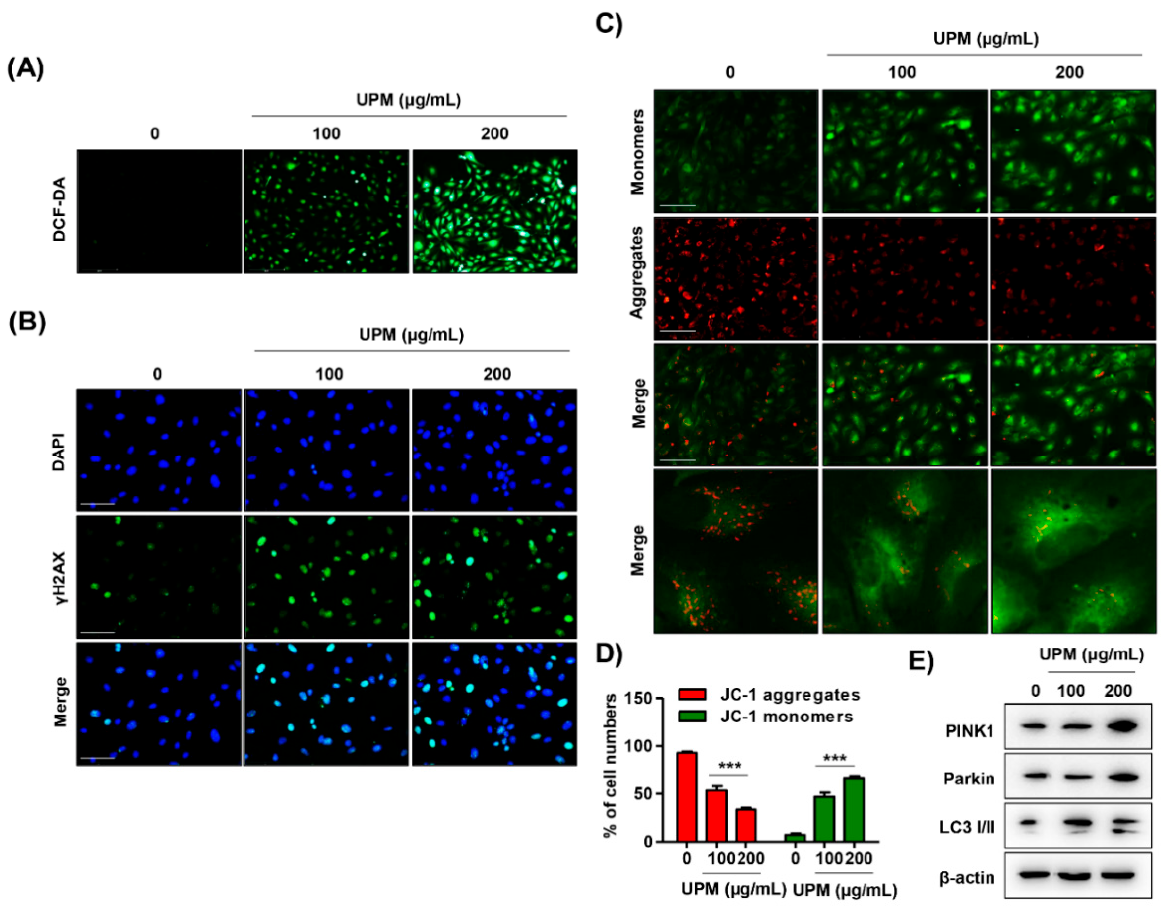
Figure 4. UPM triggers DNA and mitochondrial disorders in ARPE-19 cells. ( A ) Fluorescence images of ARPE-19 cells stained with 10 µ M DCF-DA. Intracellular reactive oxygen species (ROS) generation was identified as a DCF-DA intensity that was observed under a fluorescence microscope. Scale bar: 200 µ m. ( B ) Fluorescence images of the cells immunostained with γ H2AX antibody (green) and visualized using a fluorescence microscope. DAPI was used to counterstain the nuclei (blue). Scale bar: 75 µ m. ( C ) Fluorescence images of the cells stained with 10 µ M JC-1 with the monomer showing green fluorescence defining low MMP ( ∆Ψ m ) and aggregates showing red fluorescence characterizing high MMP ( ∆Ψ m ). Scale bar: 75 µ m. ( D ) Quantification of JC-1 red and green intensity. Data are expressed as the mean ± SD ( n = 5). *** p < 0.001 when compared to untreated cells. ( E ) The expression of mitophagy-regulated proteins.